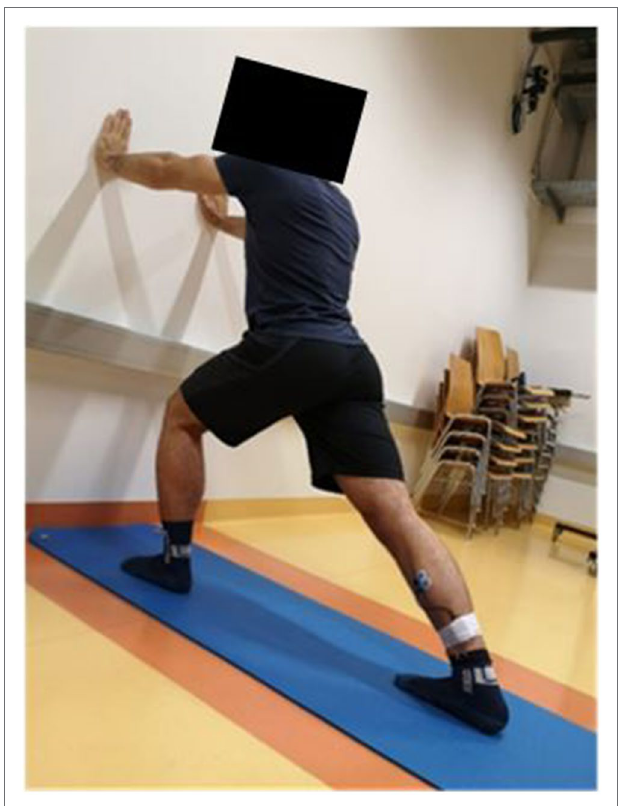
FIGURE 3 | The standing wall push exercise used for the proprioceptive neuromuscular facilitation (PNF) stretching